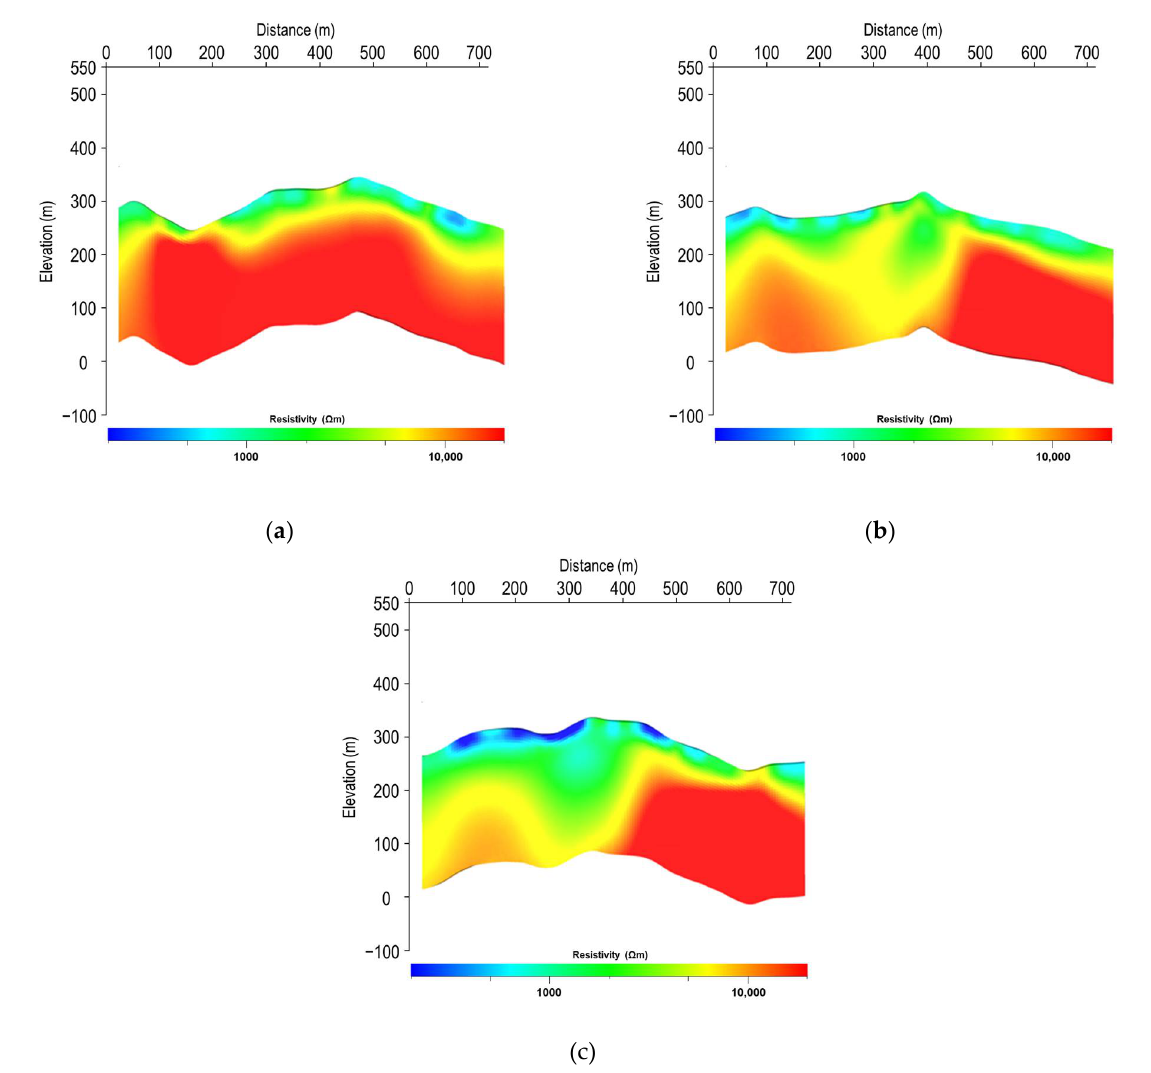
Figure 10. Two-dimensional sections of three-dimensional resistivity inversion results along ( a ) survey line 1, ( b ) survey line 2, and ( c ) survey line 3. The axis showing distance starts from the north.